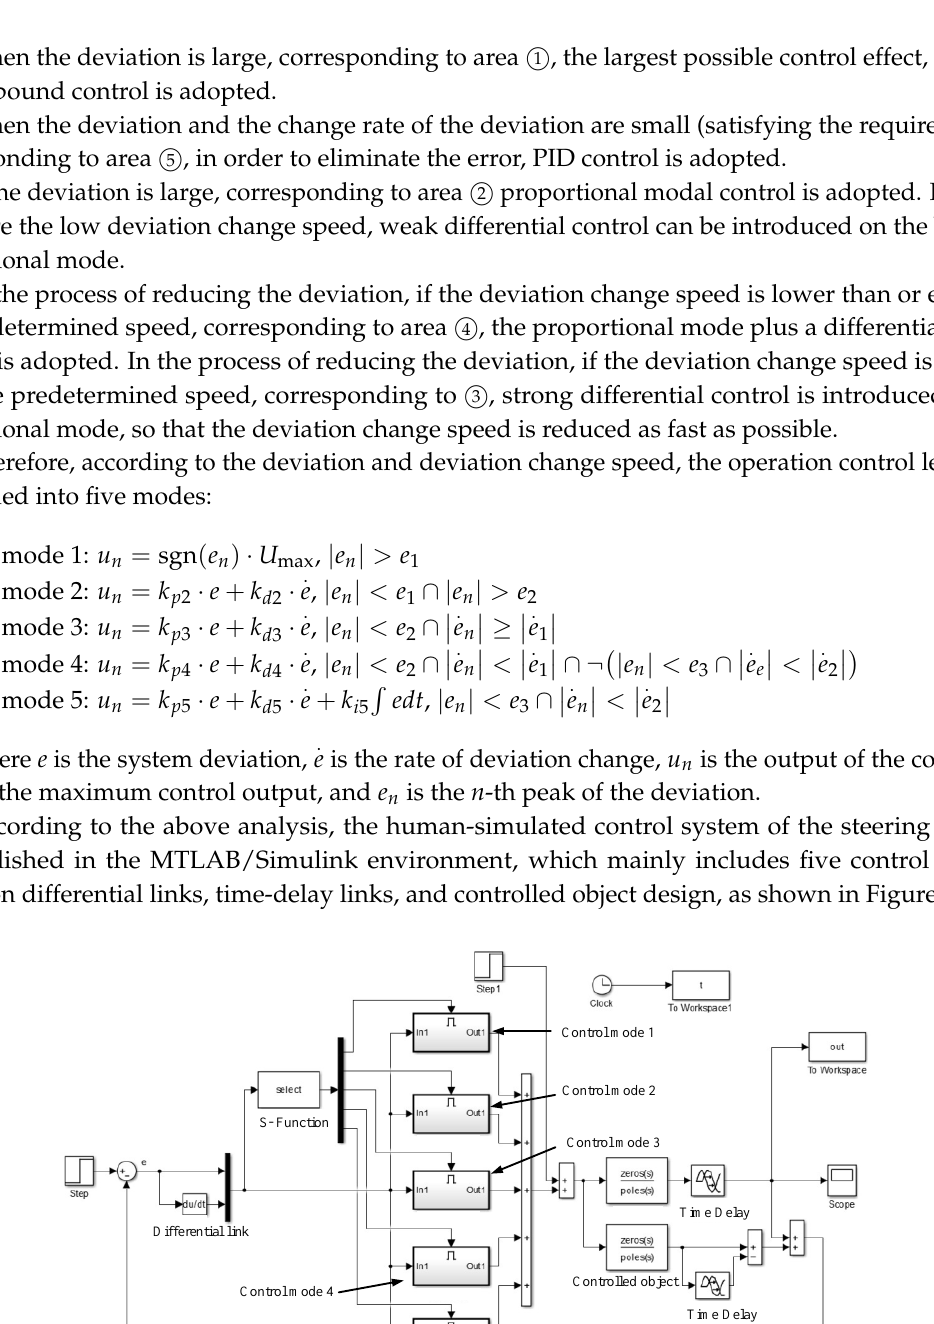
Figure 7. Overall control system based on Simulink/Carsim. 3.3. The Performance Simulation Analysis of Human-Simulated Steering Control The vehicle model parameters are shown in Table 3. Table 3. Vehicle model parameters. Parameter Name